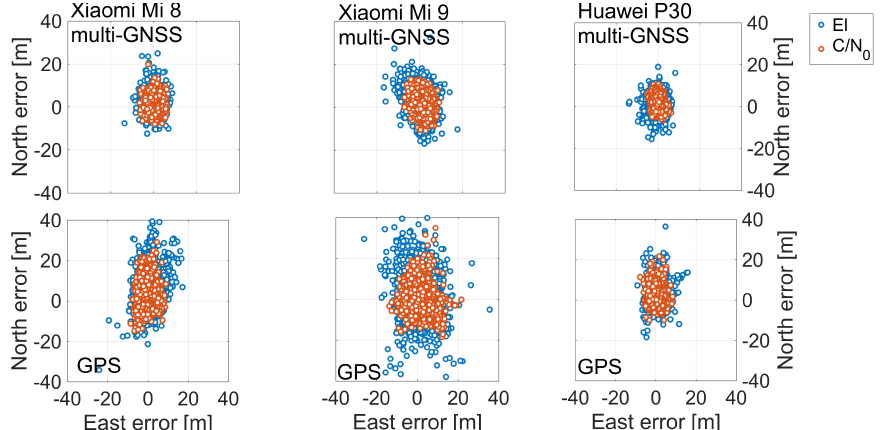
Figure 12. Horizontal coordinate component error scatter plots for single point positioning: elevation (represented in blue marker) versus C / N 0 (represented in red marker) dependent weighting schemes for multi-GNSS (first row) and GPS (second row) solutions. Xiaomi Mi 8, Xiaomi Mi 9, and Huawei P30 smartphones are shown in the left, middle, and right panels, respectively.